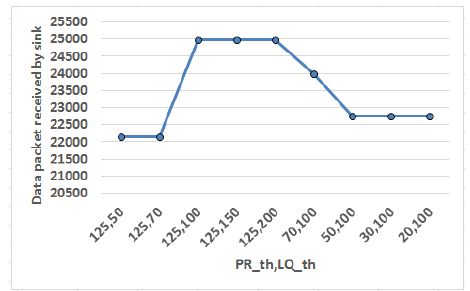
Figure 9. Obtaining threshold values for packet transmission rate ( PR th ) and link quality ( LQ th